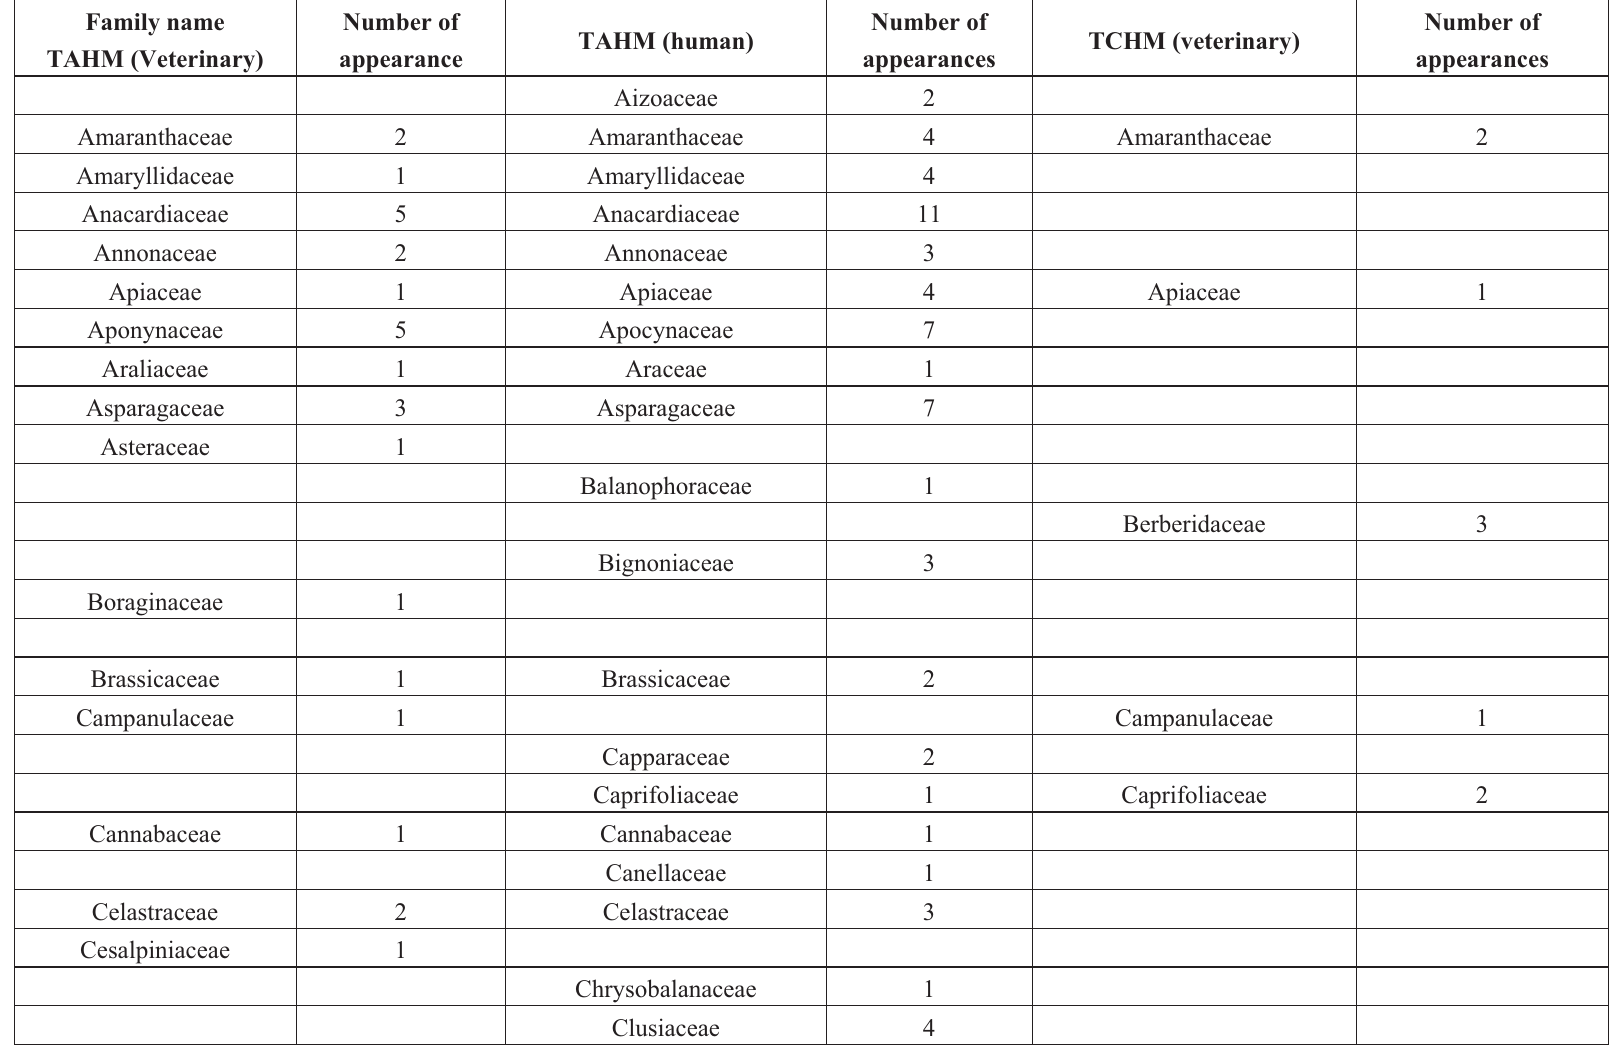
Table 3. Summary Table demonstrating the overlap and differences of plant families used TAHM (veterinary and human care) and TCHM (veterinary